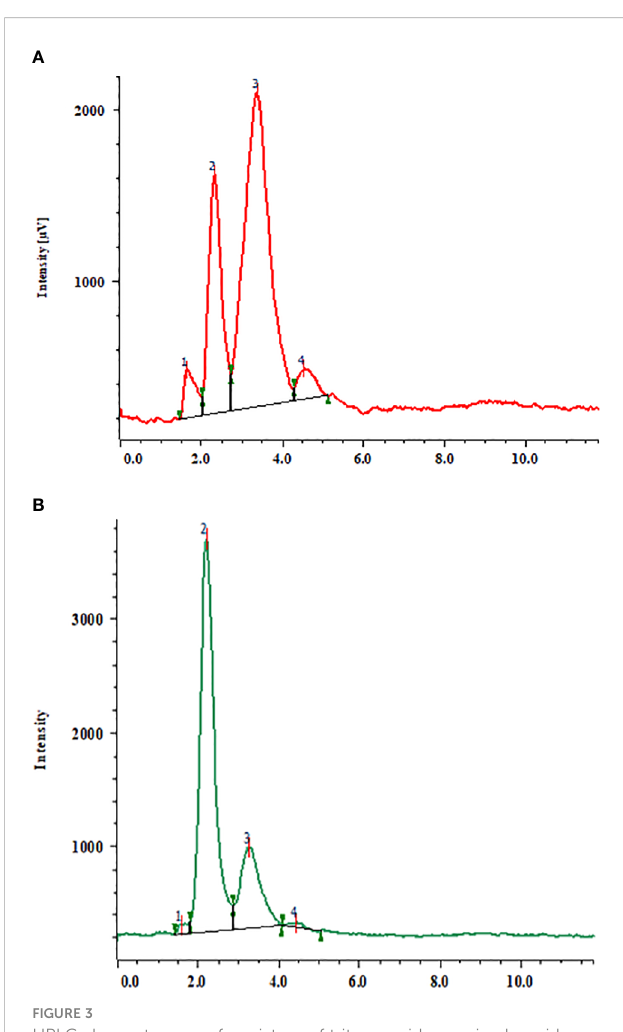
FIGURE 3 HPLC chromatogram of a mixture of triterpenoid saponin glycosides, (A) (1) bacoside A3; (2) bacopaside II; 3) bacopaside X; 4) bacopasaponin C and (B) , triterpenoid saponin glycosides from in vitro grown biomass (MS + 2.0 mg/l BAP + 1.5 m M